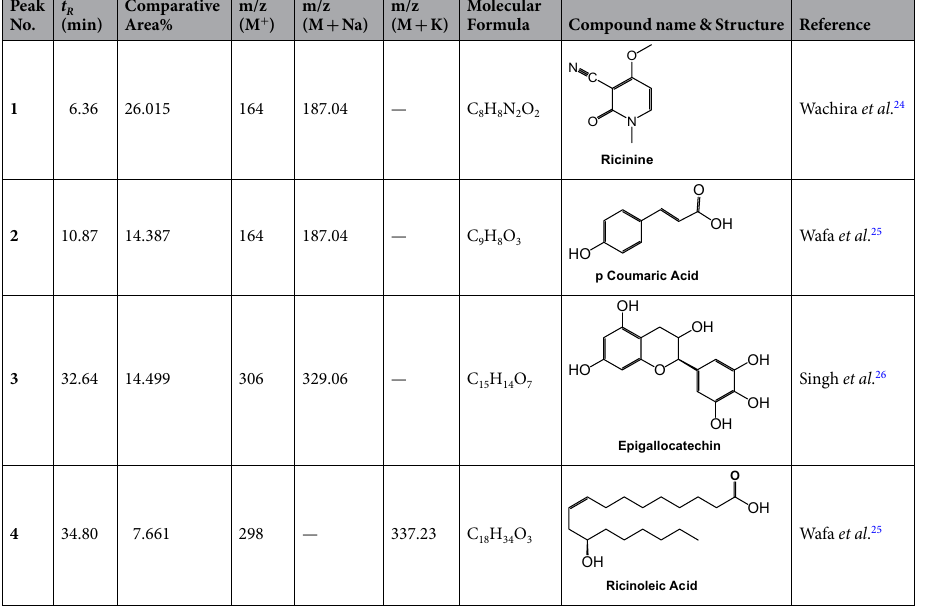
Table 1. Probable compounds identified by HPLC and ESI-MS